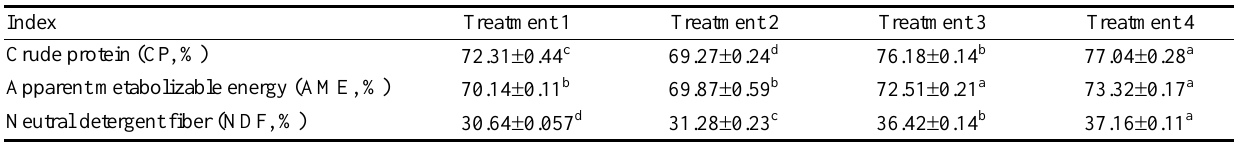
Table 4. The effect of the enzyme complex on apparent digestibility of nutrients in ducks